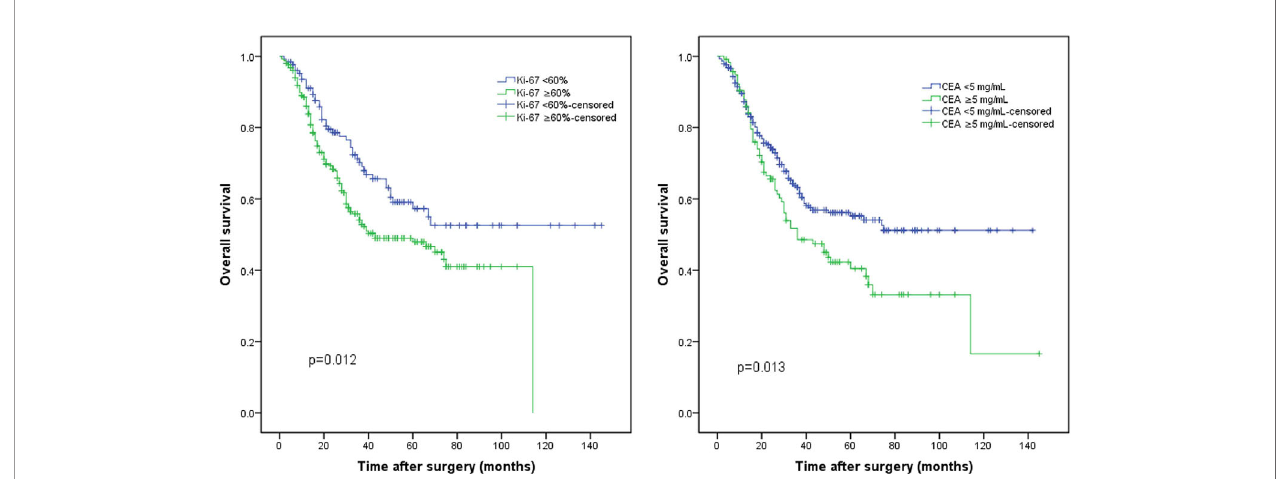
FIGURE 1 | The whole cohort was grouped according to the (A) Ki-67 index and (B) preoperative carcinoembryonic antigen (CEA) levels.